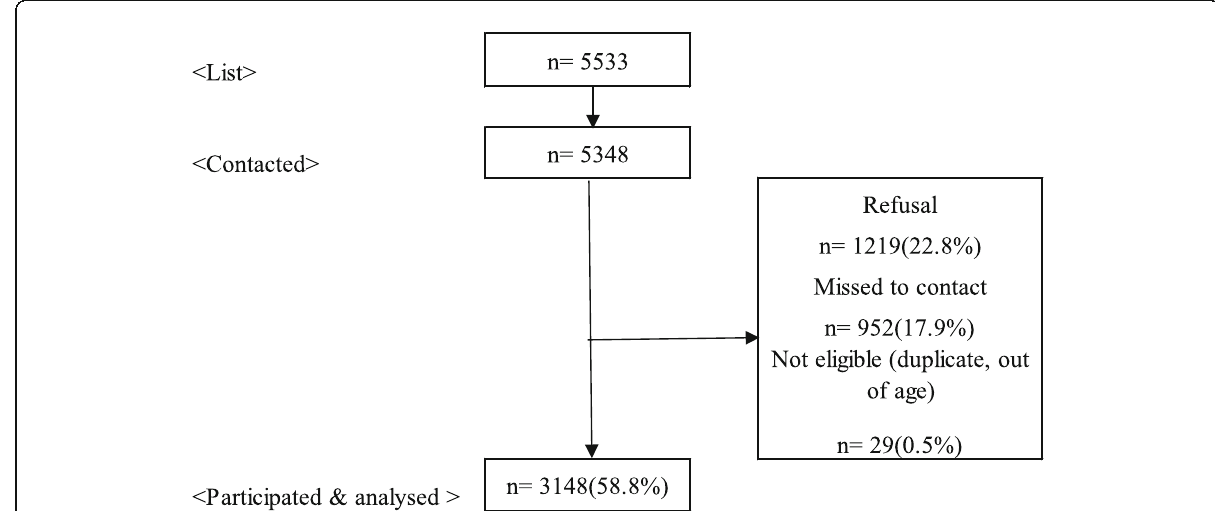
Fig. 1 Flow chart of participants. The figure displays the number of candidate in the list of 27 commune health centers, the number of contacted candidates, and the number of final participants. The number of refusal, that of missed to contact, and that of non-eligible were regarded as drop